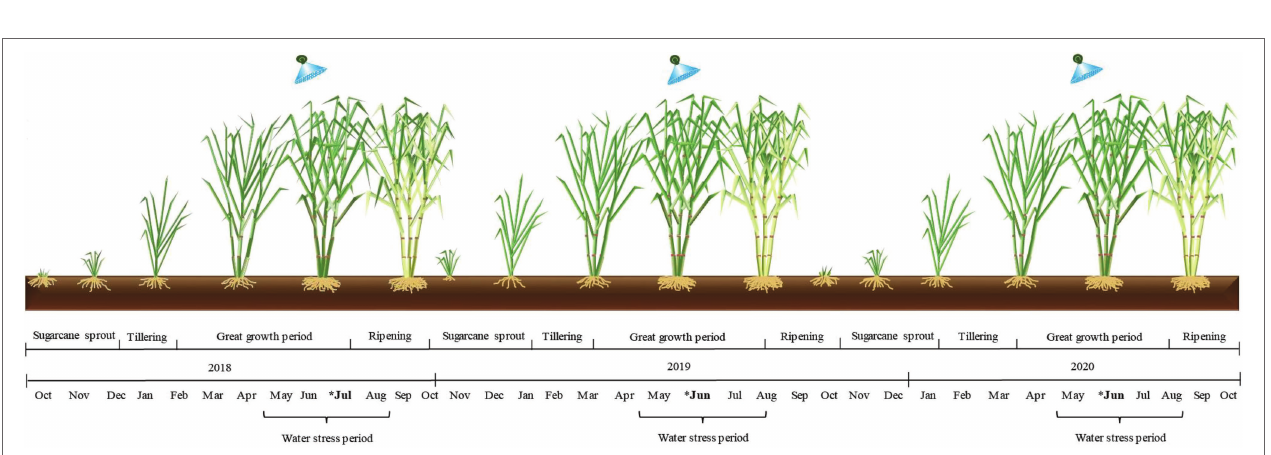
FIGURE 1 | Monthly rainfall (bars) and mean temperatures (line/squares) during experimental period of 2018, 2019, and 2020 in sites 1, 2, and 3, respectively. Different colors of gray mean different years of experiment conduction.